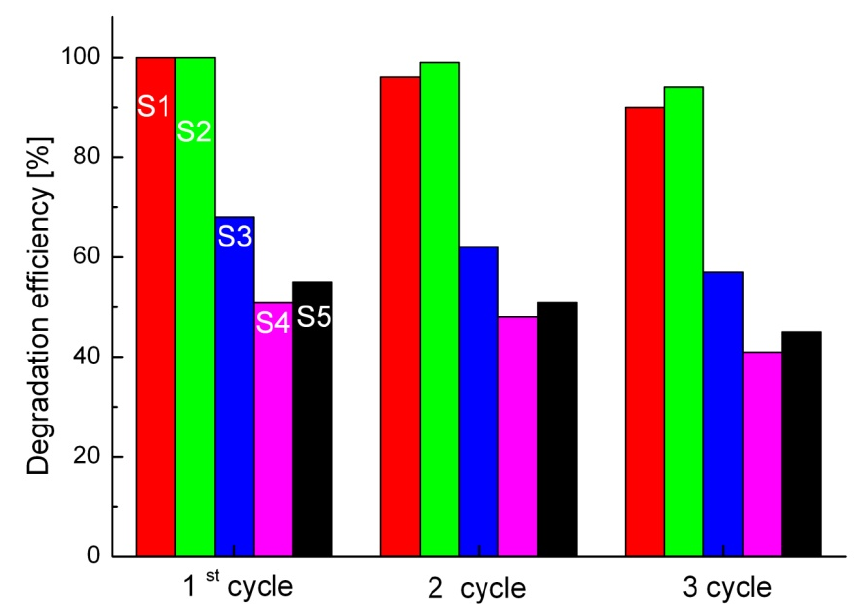
Figure 11. Reusability of prepared photocatalysts.